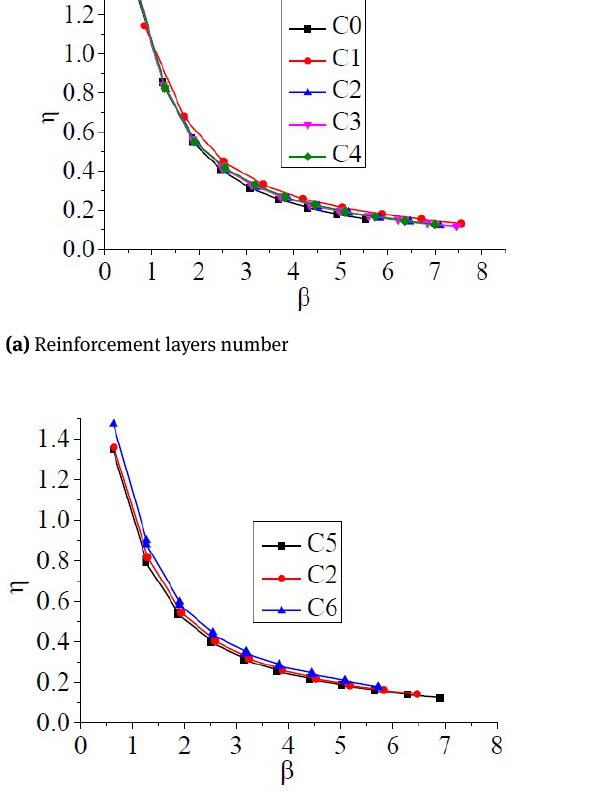
Figure 22: Accumulated energy dissipation